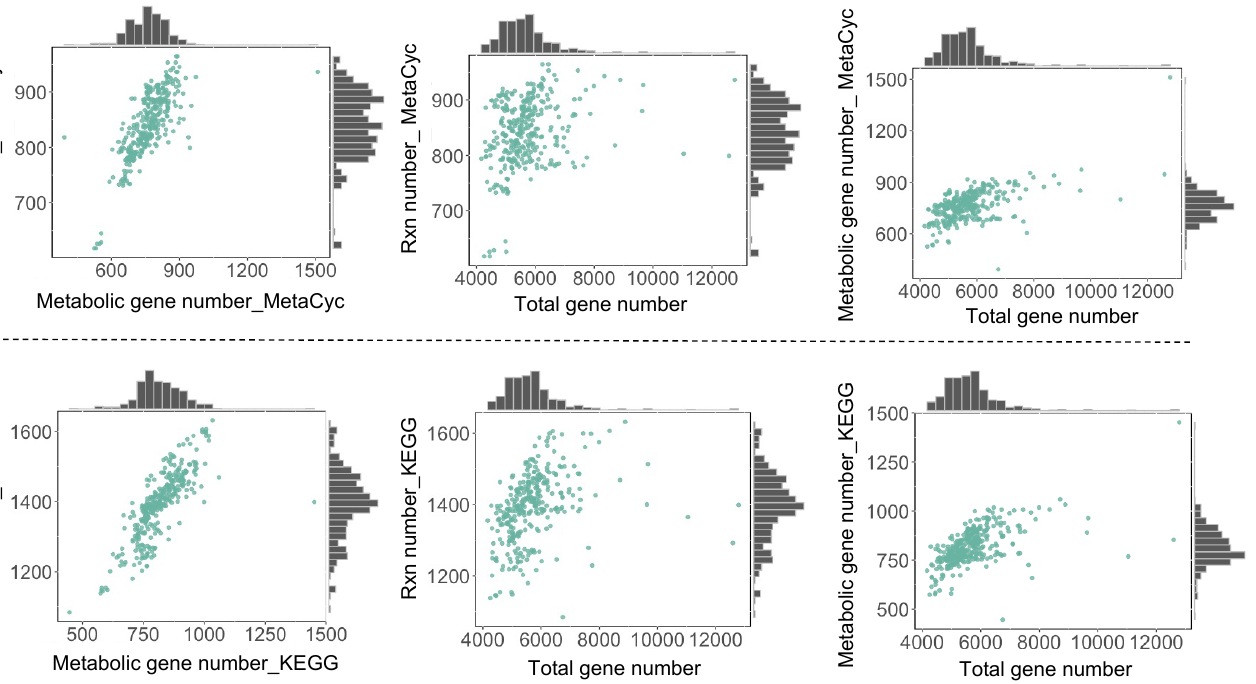
Figure 2. Total gene number determines the metabolic reaction and gene number for draft GEMs from RAVEN toolbox. Correlations among metabolic gene, reaction number, and total gene number from 332 yeast species draft models reconstructed using RAVEN getMetaCycModelForOrganism ( a ) and RAVEN getKEGGModelForOrganism ( b